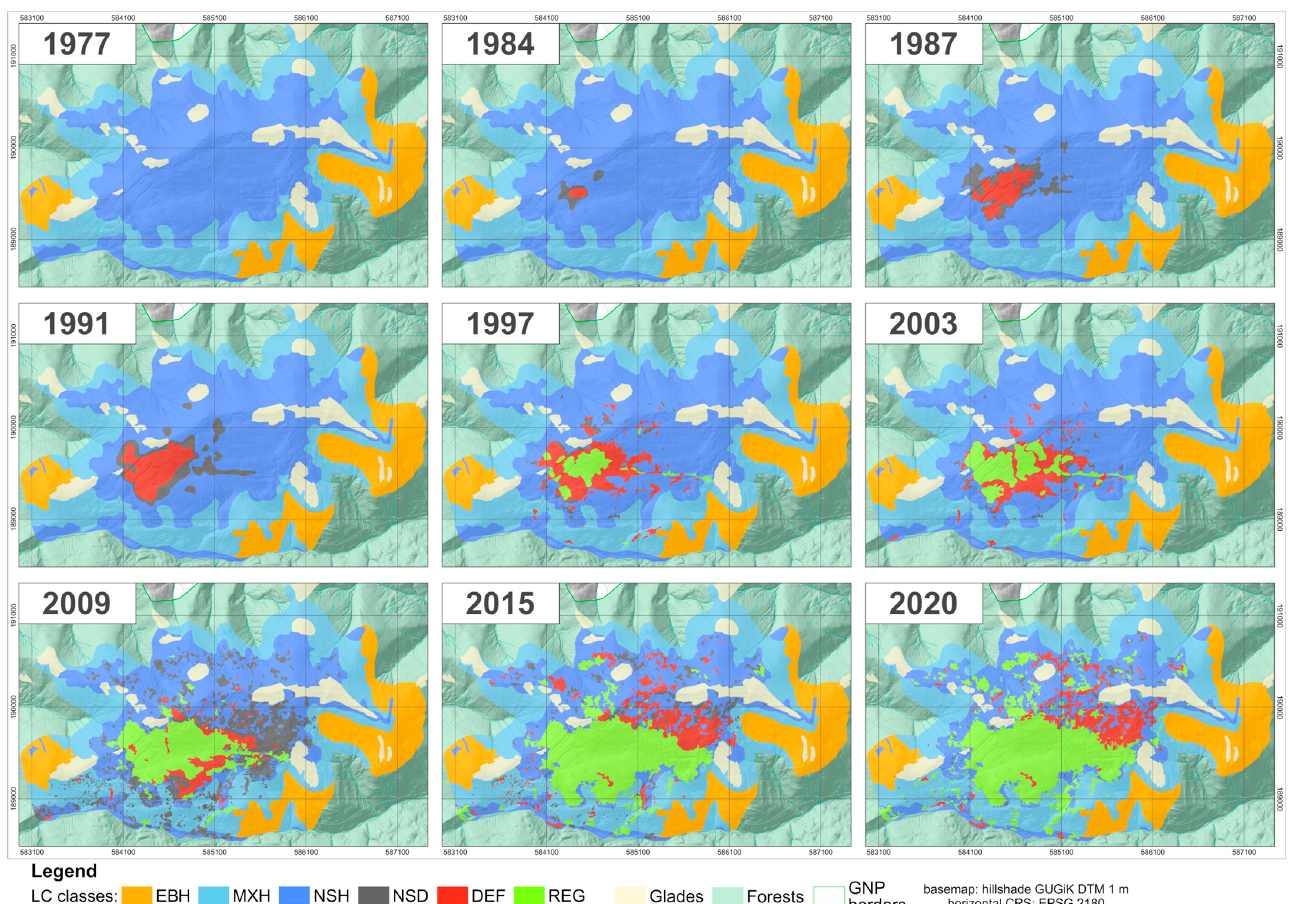
Figure A1. Land cover classes in subarea A (the Kud ł o ń range) in the analyzed time period.